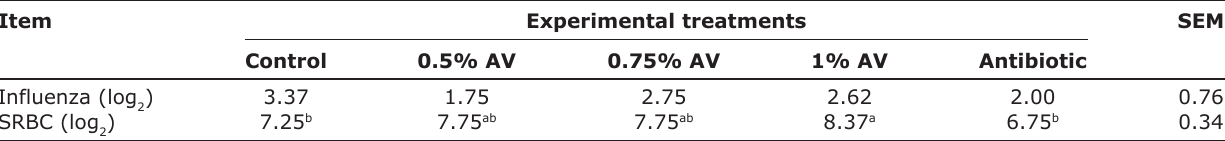
Table-6: Effect of antibiotic supplementation in the diet and AV supplementation via drinking water on antibody titers against Newcastle and influenza viruses at 28 days of age and SRBC at 31 days of age.